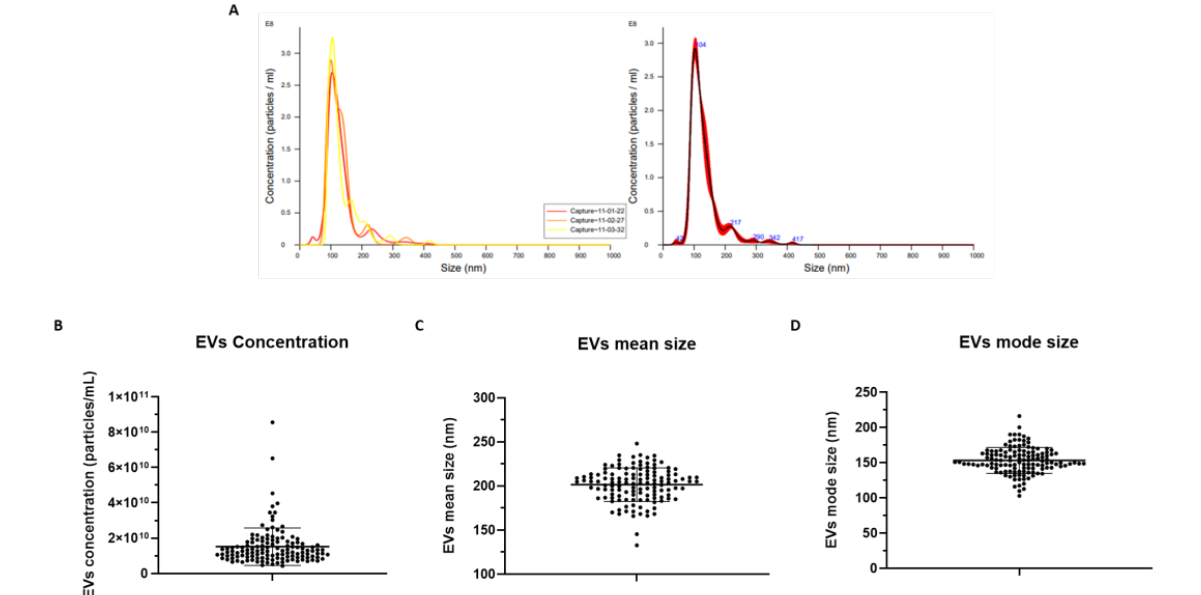
Figure 4. A representative graph of NTA measurement through NanoSight NS300 (Malvern Pana- lytical) obtained by NTA Software version 3.4, reporting the values of particle concentration in re- lation to their size. On the left, the three curves show the data captured in three 1 min videos for the same sample. On the right, the merged data ( A ). Graphs representing the EV mean concentration ([EVs/mL] ± SD) ( B ), EV mean size (nm ± SD) ( C ), and EV mode size (nm ± SD) ( D ) (n = 130).